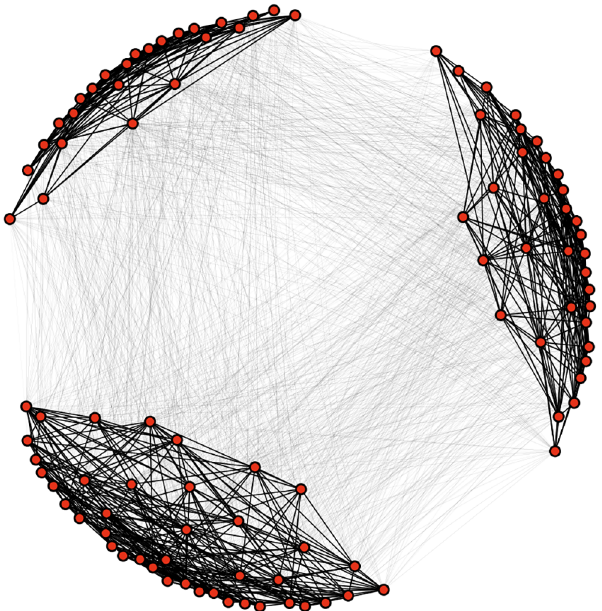
Fig 4. Transition matrix network structure. Example structure of the transition matrix with 100 nodes, N L = 20, and N C = 3 visualized as a network. The darkness of edges is proportional to the probability of a transition along that edge. Even though there are more between-cluster links than within-cluster links, within-cluster links are a factor of 1000 more likely to be followed than between-cluster links, meaning that overall a random walker tends to stay within its current